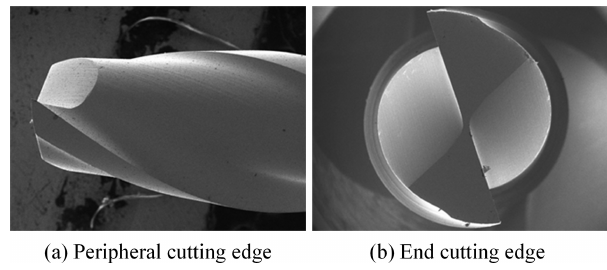
Figure 7. Cutting edge images by SEM.